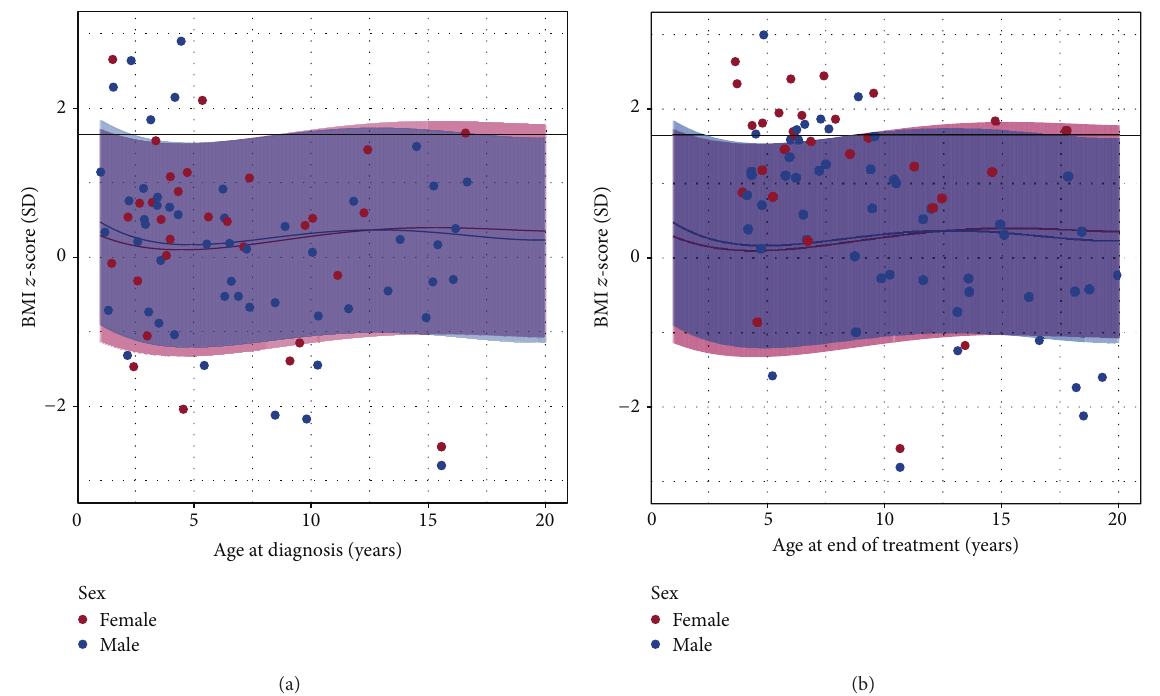
Figure 2: Scatter plot of BMI 𝑧 -scores (in standard deviation (SD) units) for each individual at (a) diagnosis and (b) end of treatment. Red (female) and blue (male) shaded areas represent 95% prediction intervals from healthy (Raine study) individuals and colored lines represent mean healthy BMI 𝑧 -scores. The black horizontal line indicates the CDC cut-off for the obese BMI category. There is a marked increase in the number of individuals in the obese category at the end of treatment.